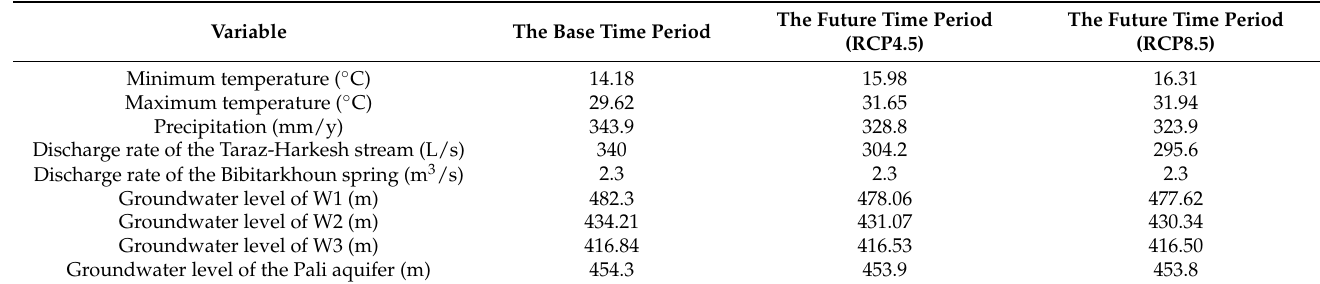
Table 2. The average of climatic and hydrological variables for different water systems in the Lali region in the base and future time periods, considering RCP4.5 and RCP8.5.